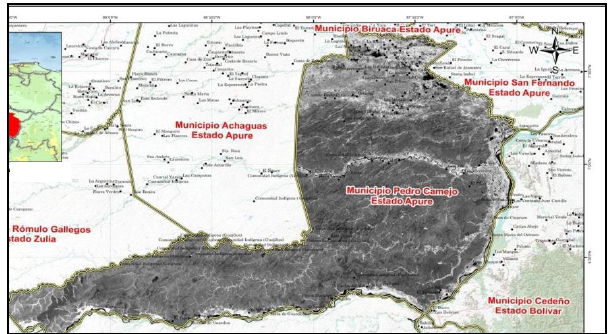
Figure 1. Image fraction of the soil component